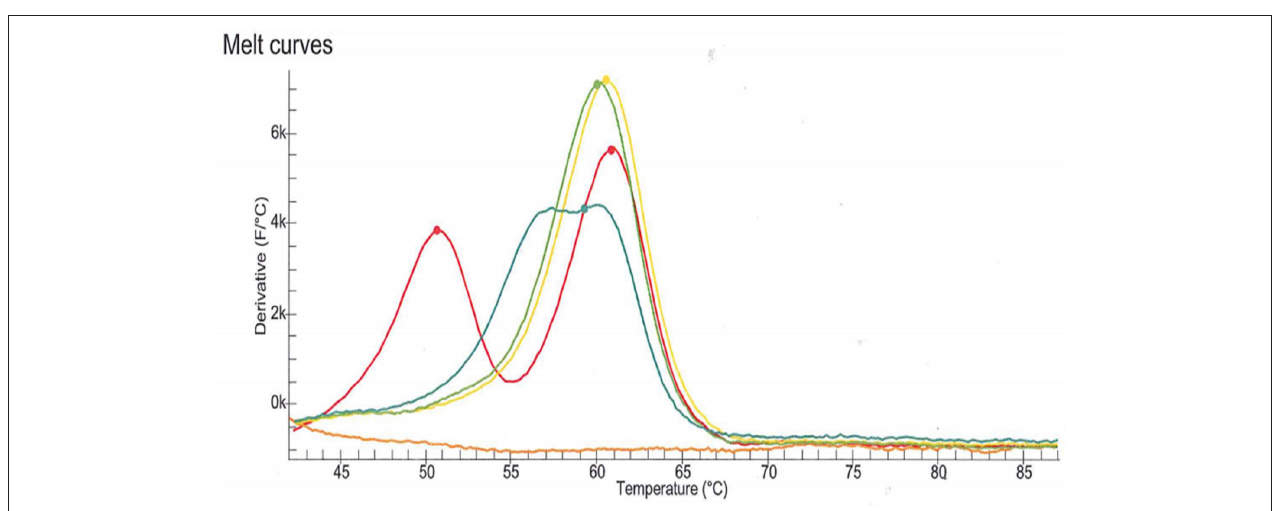
FIGURE 1 | Melting curve relative to rs3918290 (c.1905 + 1G > A) genotyping using LAMP Human DPD deficiency kit (LaCAR MDx Technologies, Lièges, Belgium). The melting curve observed with the patient sample (blue line) is clearly different from those associated with the wild-type genotype (green and yellow lines) and the heterozygous genotype (red line). This atypical profile of the melting curve suggested the presence of an uncommon SNP.